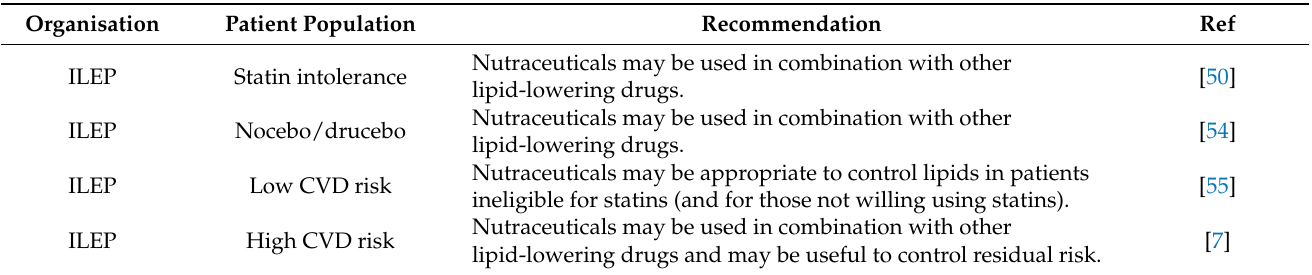
Table 1. Summary of recommendations on the use of nutraceuticals in dyslipidaemias and atherosclerosis. Organisation Patient Population Recommendation Ref Nutraceuticals may be used in combination with other ILEP Statin intolerance lipid-lowering drugs. Nutraceuticals may be used in combination with other ILEP Nocebo/drucebo lipid-lowering drugs. Nutraceuticals may be appropriate to control lipids in patients ILEP Low CVD risk ineligible for statins (and for those not willing using statins). ILEP High CVD